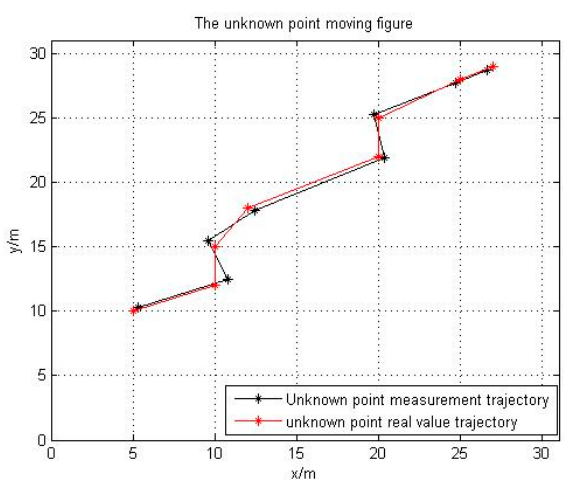
Figure 13. Error result between the ideal point and the measured (computed) point. Table 2. RMS error result between the ideal point and the measured (computed) point.